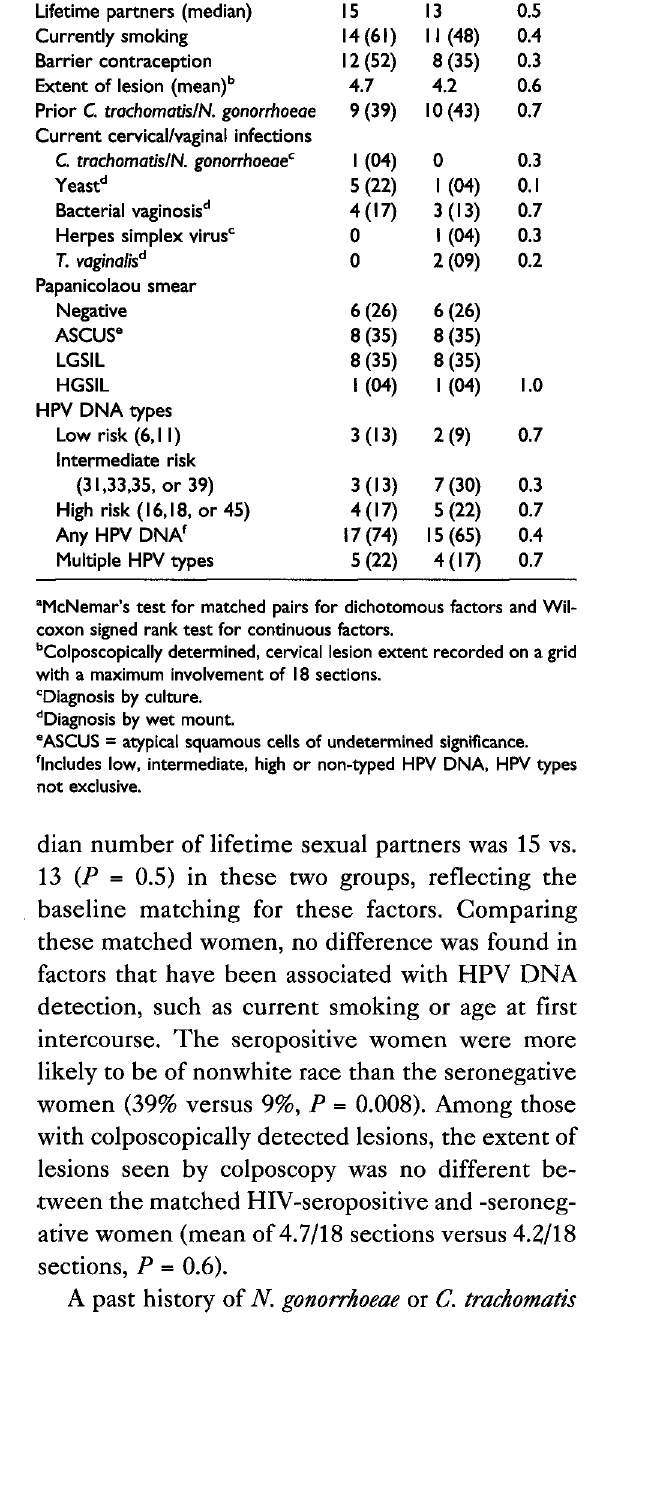
TABLE I. Baseline characteristics of HIV-seropositive and HIV-seronegative populations matched for age, number of lifetime sexual partners, and cervical cytology